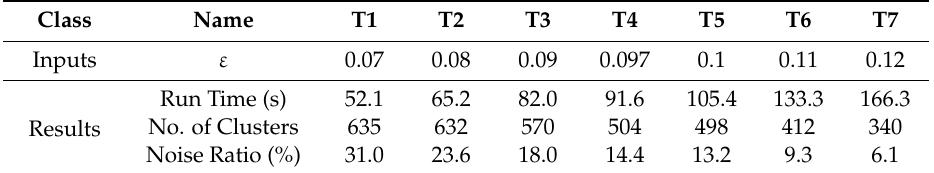
Table 3. The segmentation results using different thresholds for airborne laser scanning data using X , Y , Z , R , G , B fields.